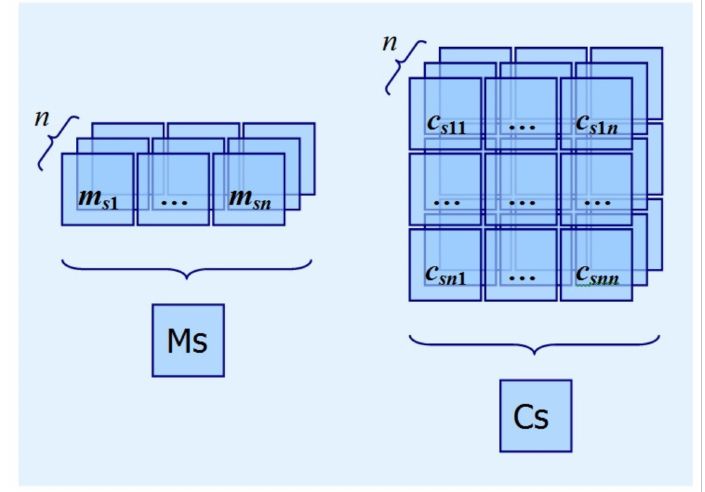
Figure 11. Object representation of matrices M s and C s